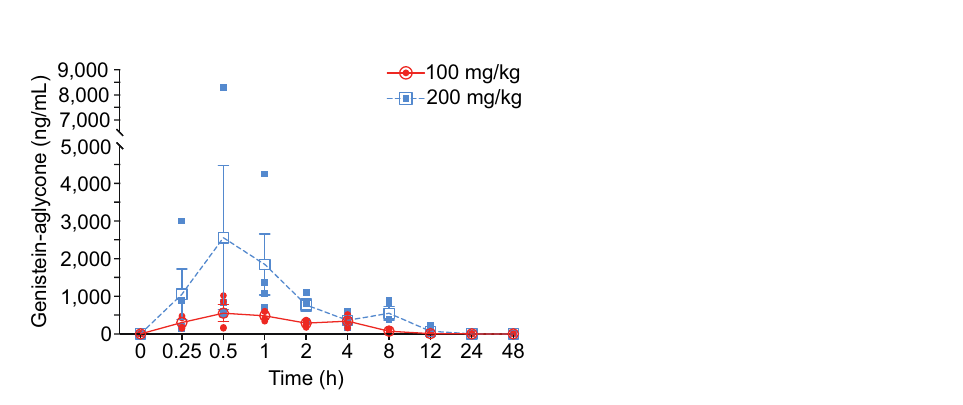
Figure 2. Pharmacokinetic analysis of BIO 300 Oral Powder formulation for two doses (100 mg/kg and 200 mg/kg). Open Symbols are the average of N = 4 NHPs. Closed symbols are the individual NHP genistein- aglycone concentrations for the color-matched dosing groups. Error bars are standard error, and they are not shown when the error bars are smaller than the